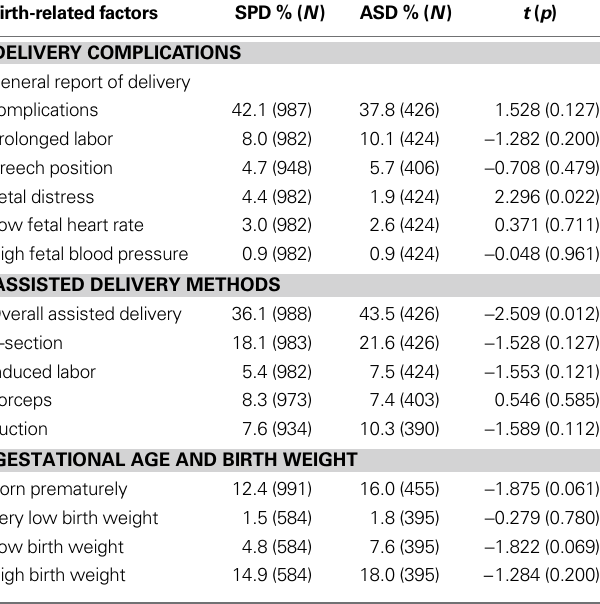
Table 4 | Percentage, valid N , and T -test for birth and delivery-related